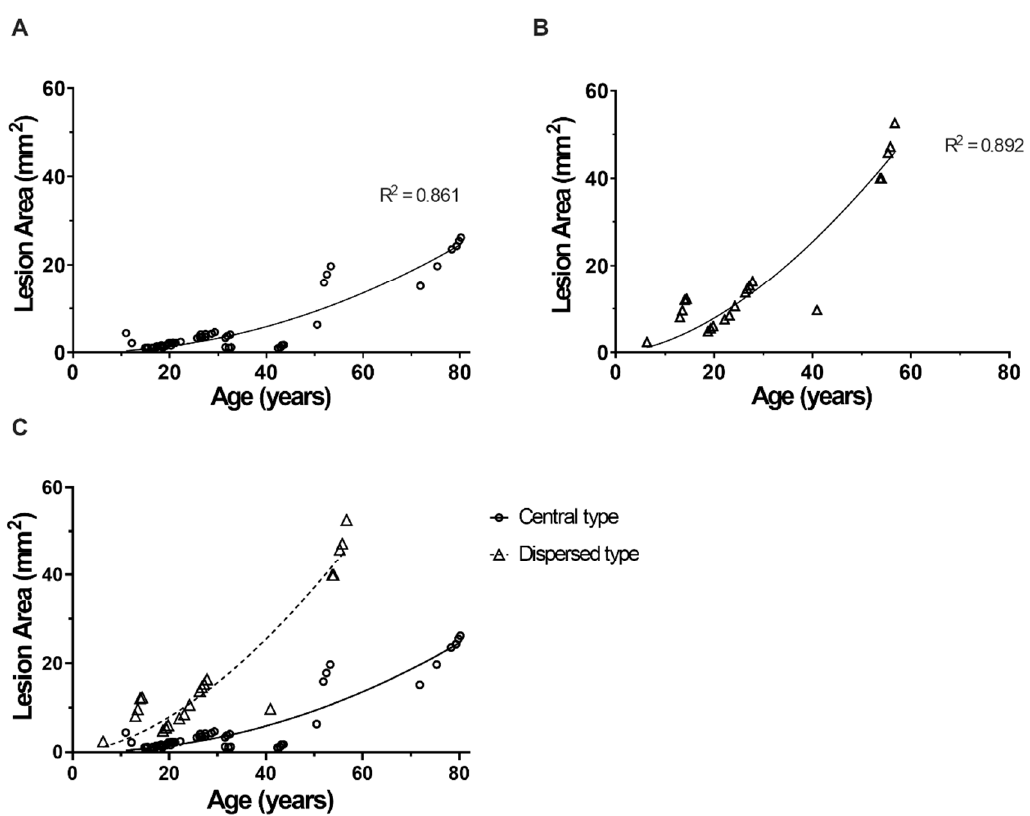
Figure 2. Fundus autofluorescence lesion areas in patients with Stargardt disease 1 across di ff erent age groups. ( A ) Central type Stargardt disease 1. ( B ) Dispersed type Stargardt disease 1. ( C ) Comparison of the central type and dispersed type lesion areas in different age groups.